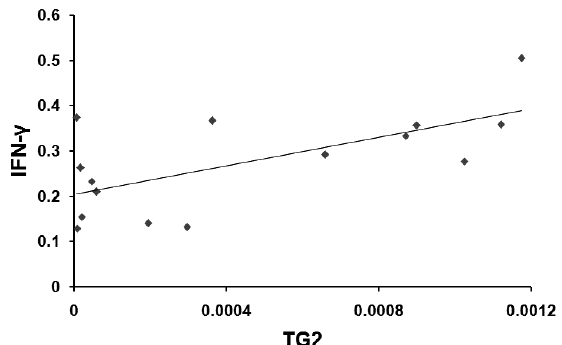
Figure 2. Relationship between TG2 and IFN- γ mRNA levels in foreskin from patients with BXO. TG2 mRNA transcript amount showed a positive correlation with the IFN- γ mRNA ( r = 0.653; p = 0.008).